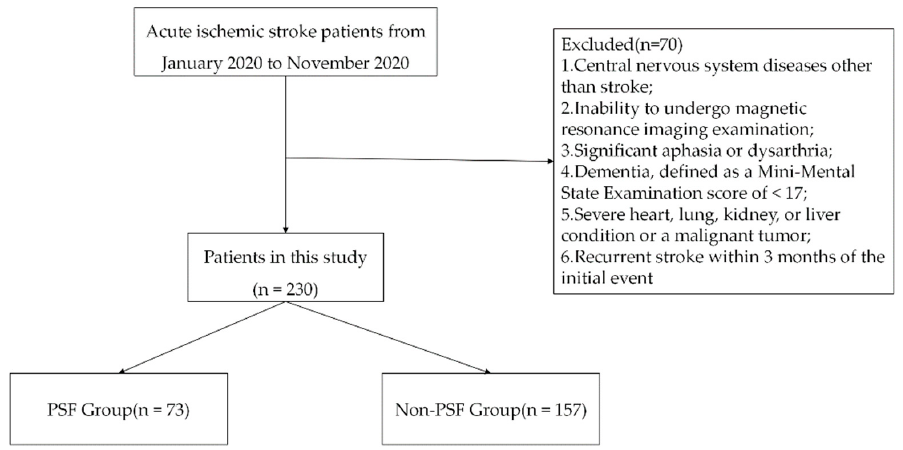
Figure 1. Flow diagram of patient recruitment within the stroke registry data. PSF, post-stroke fatigue.